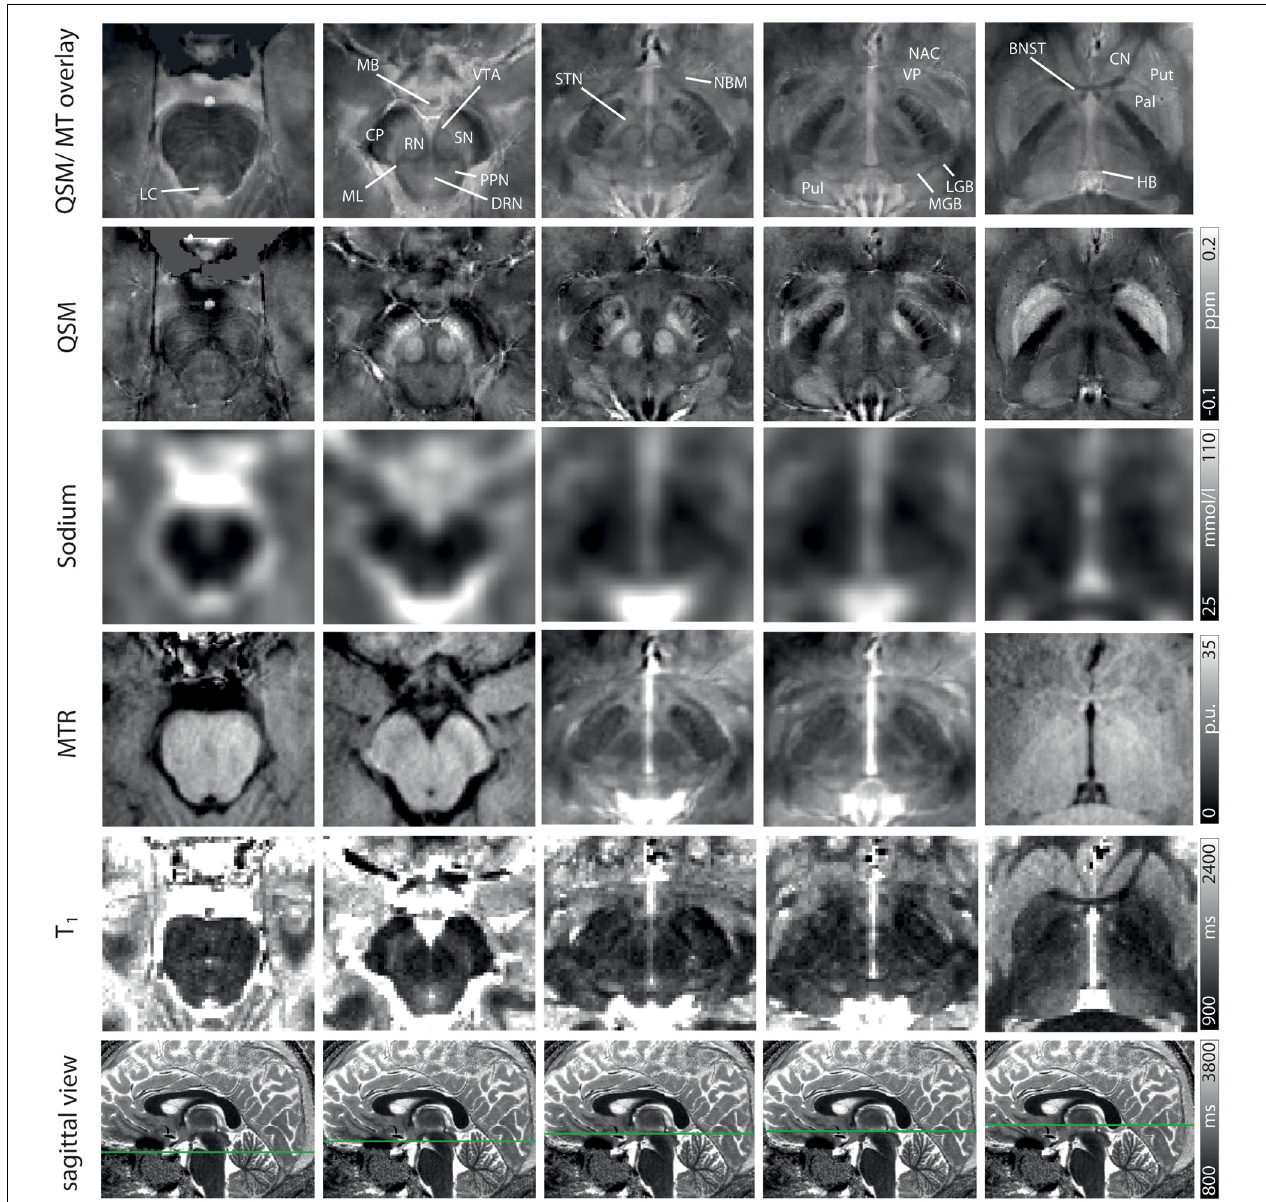
FIGURE 2 | Representative axial slices at five indicated levels of the midbrain for a QSM/MT overlay, QSM, sodium images, MTR w, T 1 from Row 1–5. In Row 6 the axial level of each row of images is indicated on sagittal T 1 -maps. Structures are indicated on the QSM/MT overlay. All data were co-registered to the gradient echo data which were used to calculate